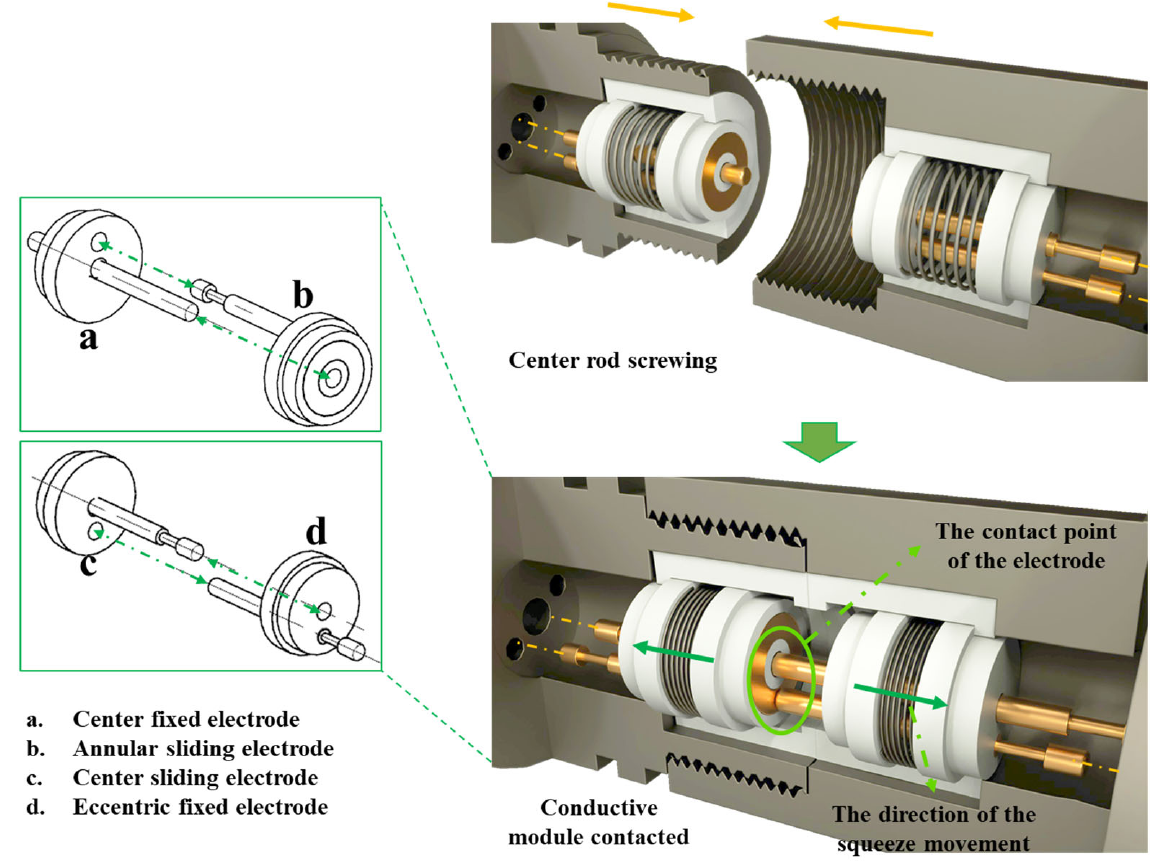
Figure 19. The final design of the conductive center pole.